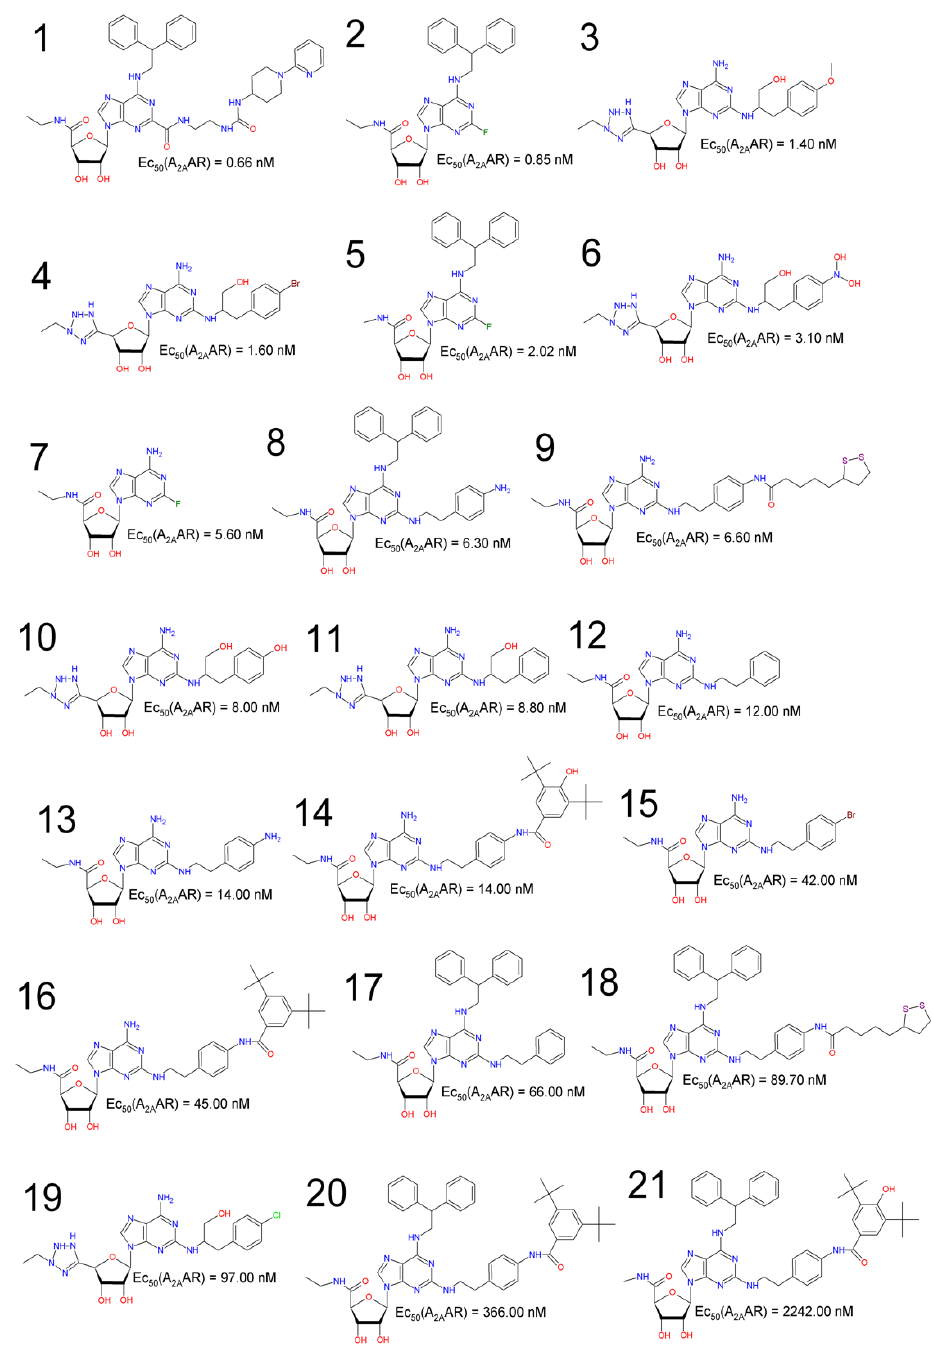
Figure 15. Selected compounds with their respective EC 50 (A 2A AR) values.